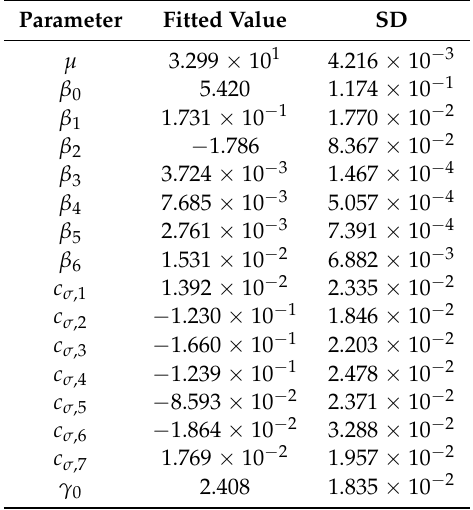
Table 5. Estimated parameters for model (16)–(18).